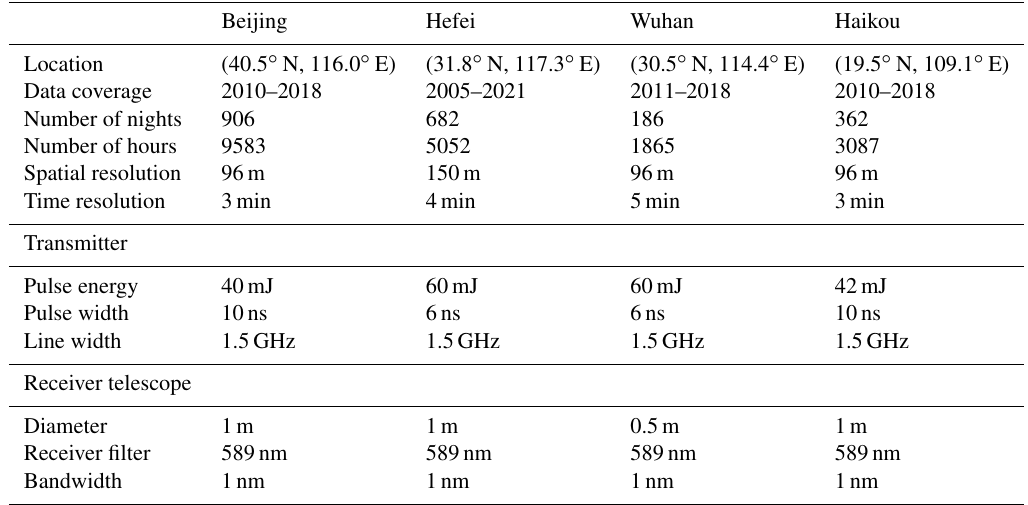
Table 1. Na lidar measurements and main parameters of the Na lidars.